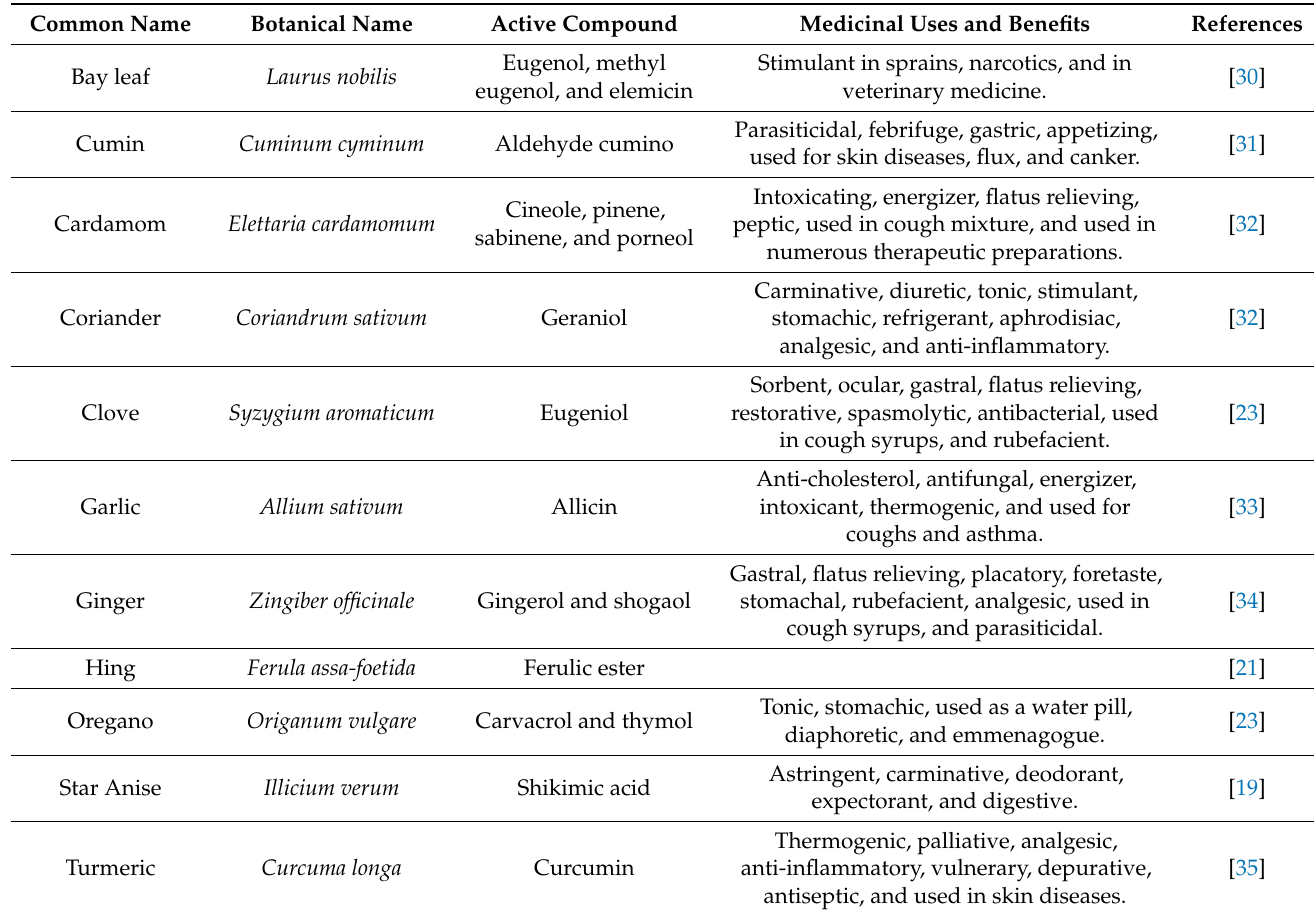
Table 1. Active compounds and medicinal uses of some